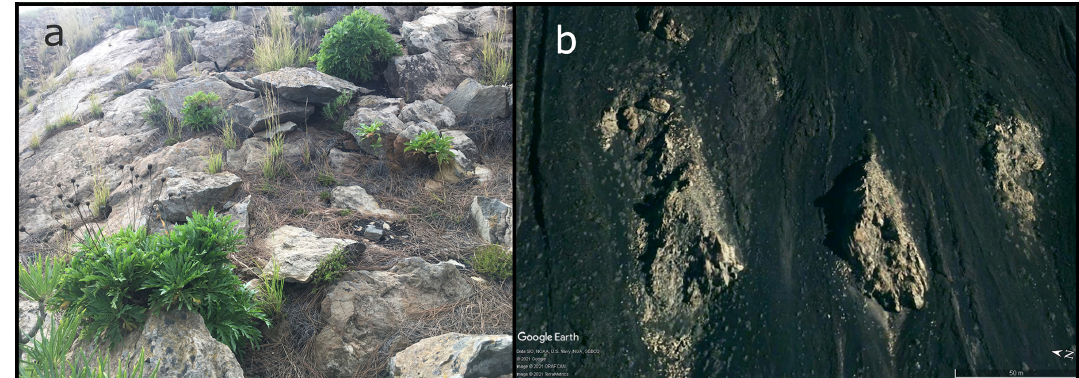
Figure 1. The endemic Cheirolophus junonianus ( a , bottom left) and further plant species on a phonolite rock (© Severin Irl). Aerial image of rocks of phonolites isolated in a basaltic matrix in southern La Palma ( b , © Google Earth